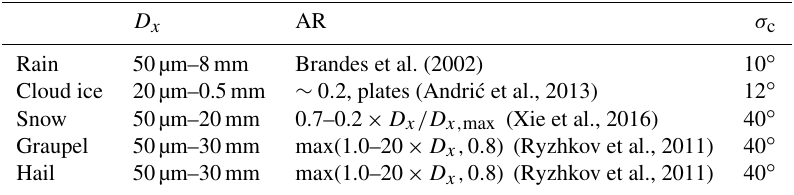
Table 3. Assumed hydrometeor physical properties for T -matrix computation in the